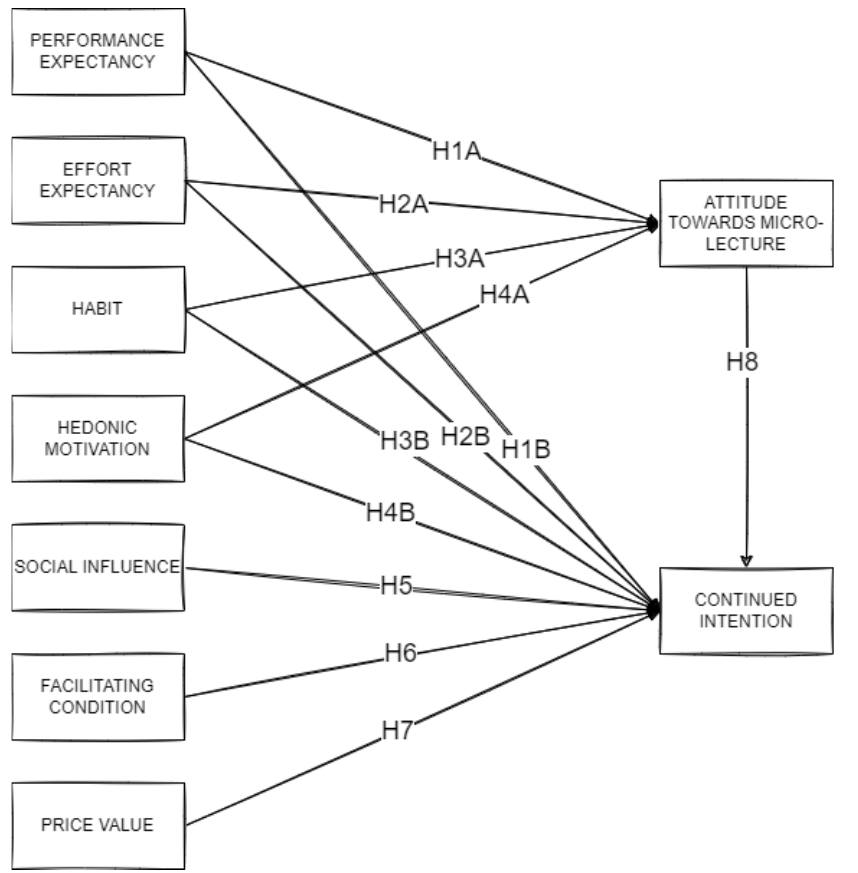
Figure 2. The proposed model and hypothesis.